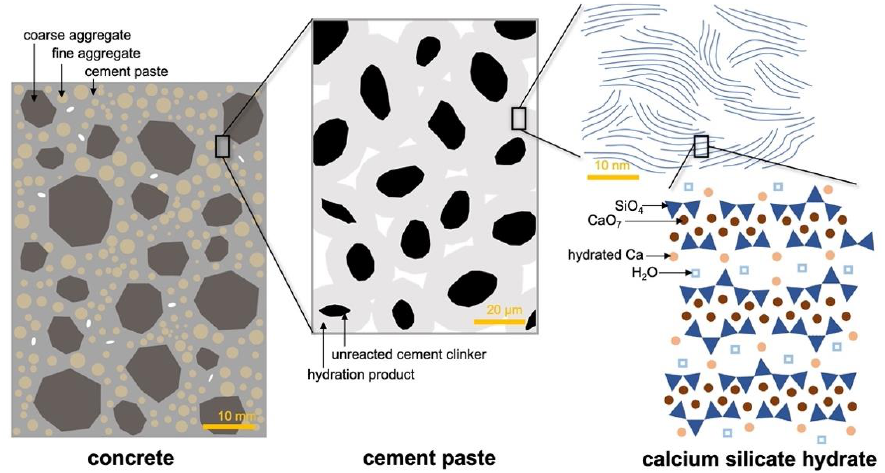
Figure 1. Schematic diagrams of concrete at different scales (derived from [61,64–66]). C-S-H is mesoporous with high surface areas. Hydrated Ca of C-S-H can be substituted by HMs, and the layered nanostructure adsorbs many organics and ions.